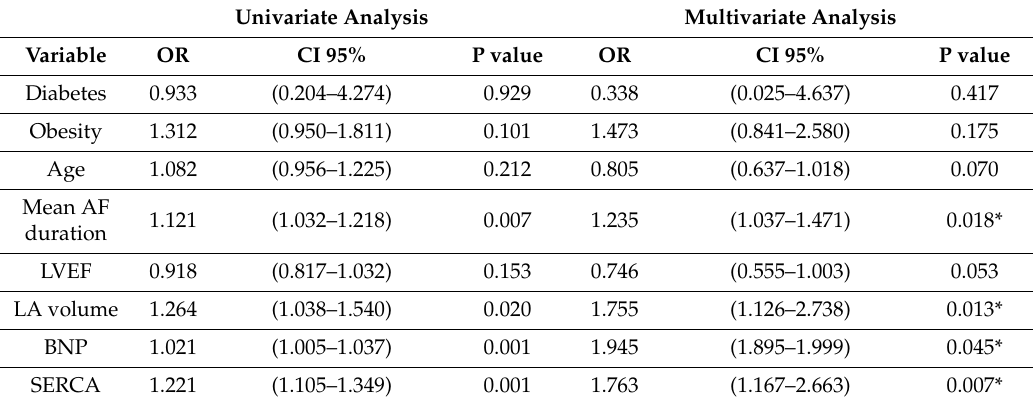
Figure 1. Baseline (top) and follow-up end (bottom) levels of sarcoplasmic endoplasmic reticulum calcium ATPase (SERCA) in nanograms / milliliters (ng / mL). In the left part of the figure, the SERCA levels are represented by columns with mean values ± standard deviations in overall population (blue), and responders (green color) vs. nonresponders (red) patients. On the right part of the figure, the dispersion graph represents the values of SERCA in responders (green) vs. nonresponders (red color). The symbol “*” marks a p value < 0.05 as statistically significant. Table 2. Univariate and multivariate analysis for atrial fibrillation (AF) recurrence after epicardial ablation at 12 months of